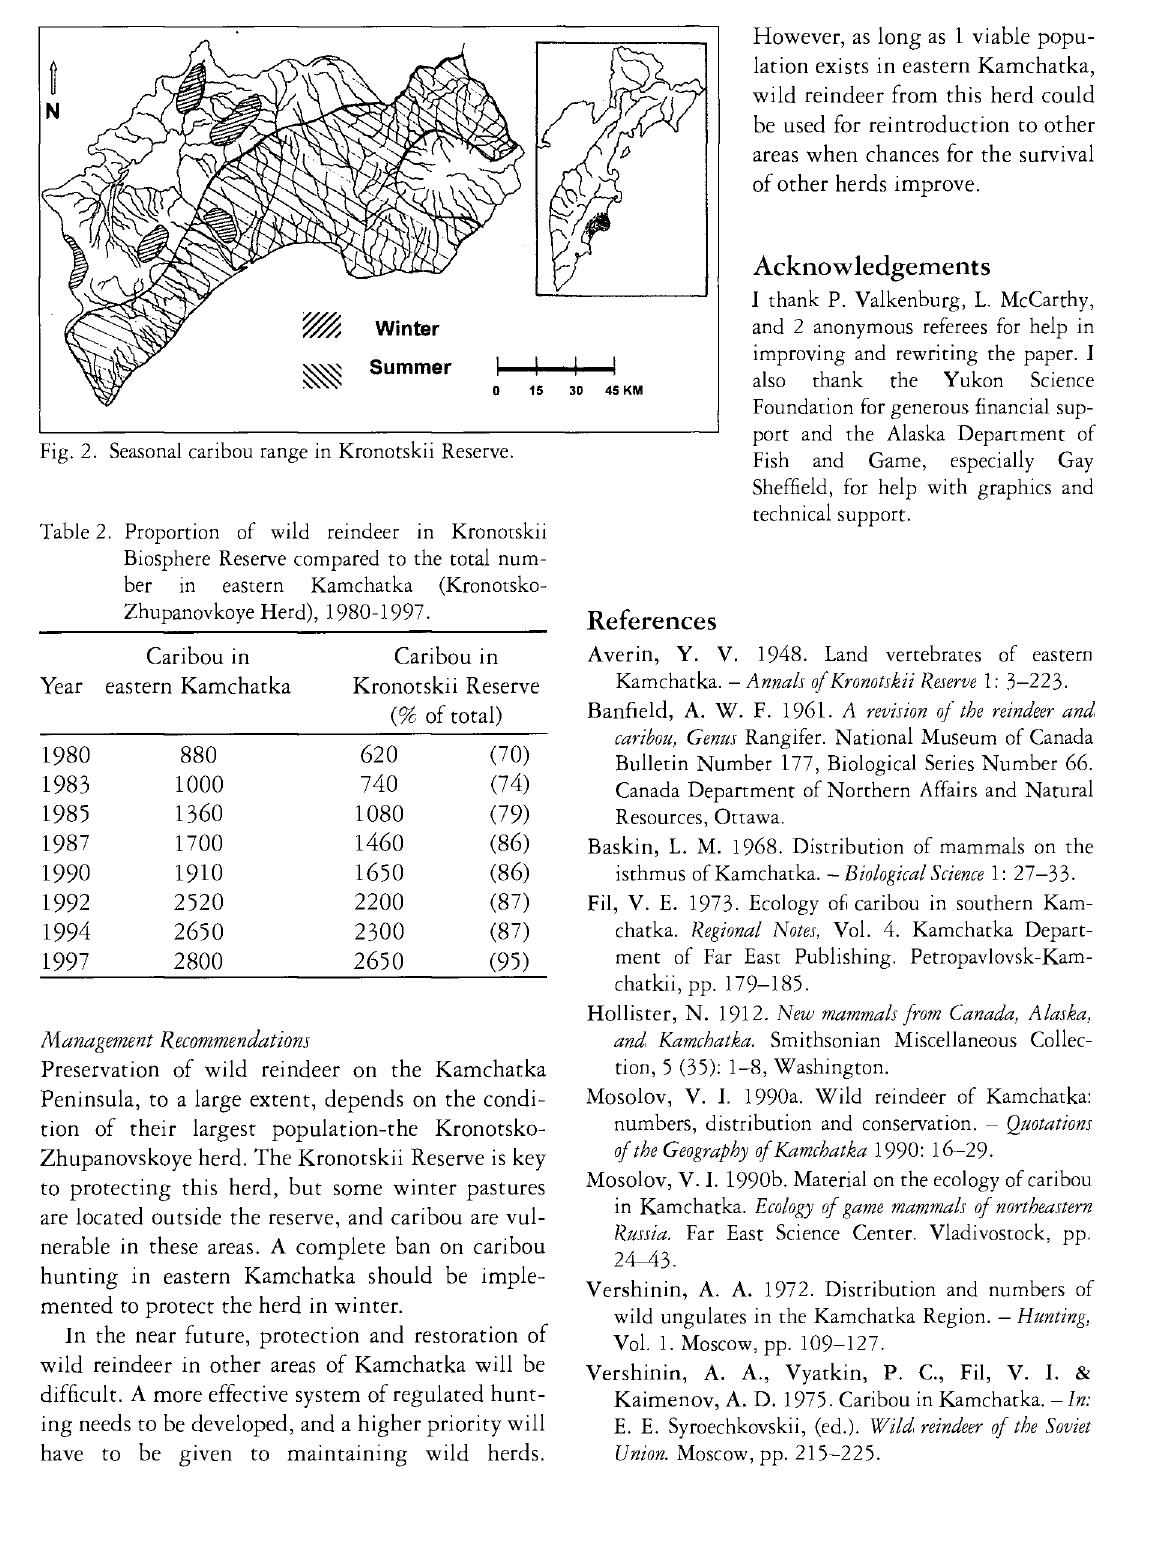
Table 2. Proportion of wild reindeer in